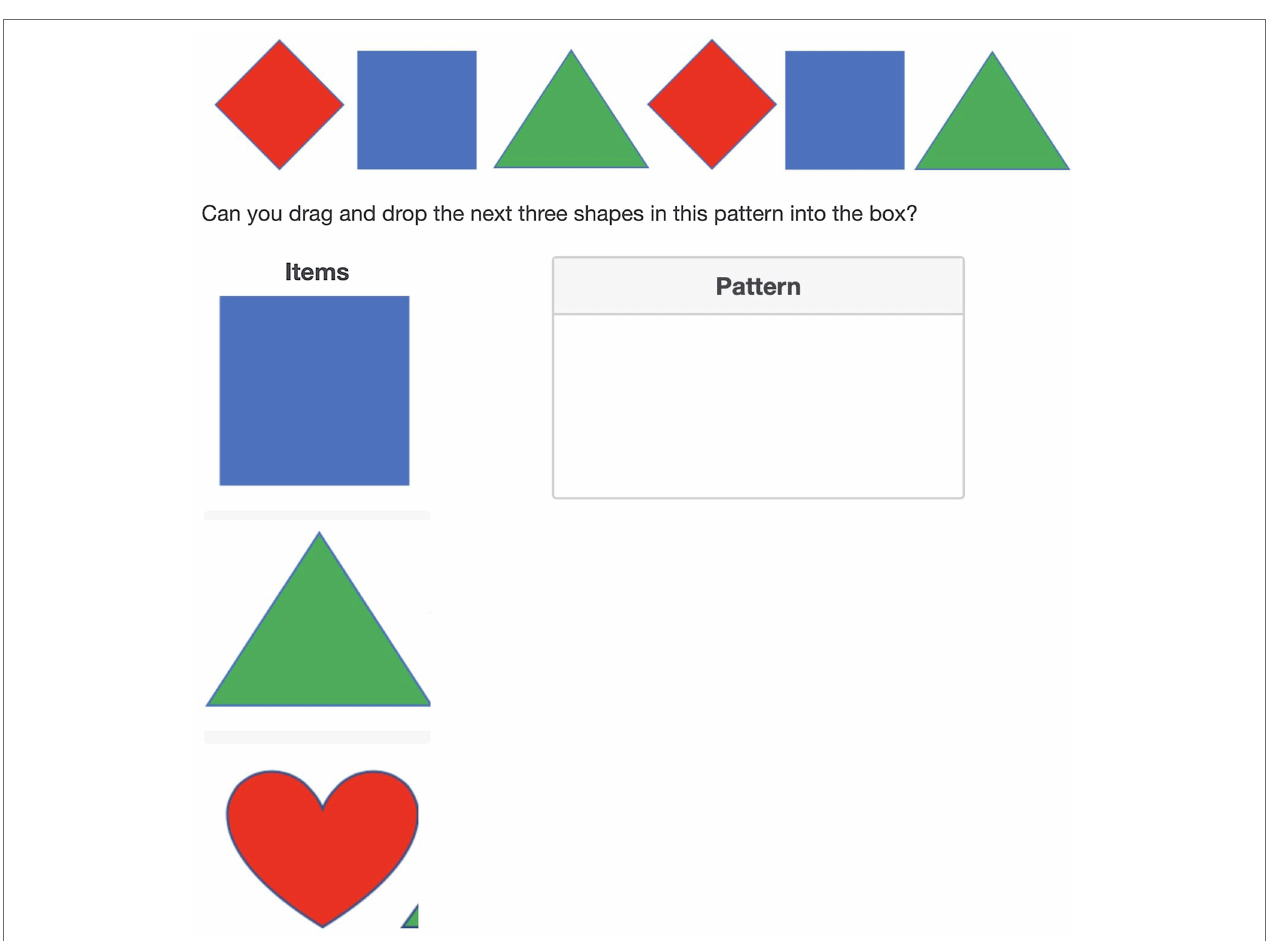
FIGURE 2 | Example trial from the pattern